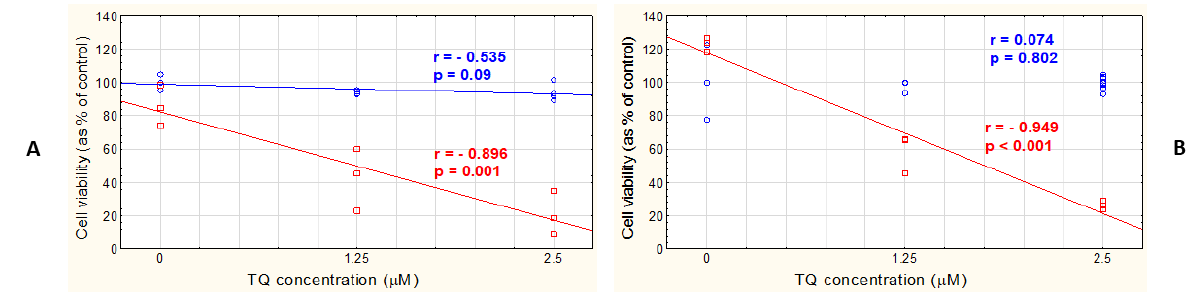
Figure 9. TQ-LP exerts its antiproliferative effect at low TQ concentrations in A375 and WM9 cells. Cytotoxicity assessment (WST-1) in the two melanoma cell lines: A375 ( A ) and WM9 ( B ) treated with low concentrations of free TQ (blue curve and circles), or TQ in liposome (red curves and rectangles), for 48 h. Spearman correlation analysis of the data shows the relationship between free TQ (or TQ in LP) concentration and cell viability. Where 0 denotes DMSO control (blue circles), or an empty liposome control (red squares). Spearman correlation coefficient (r) and p -value are shown; data are presented as mean ± SD; p < 0.05 was considered to be statistically significant.